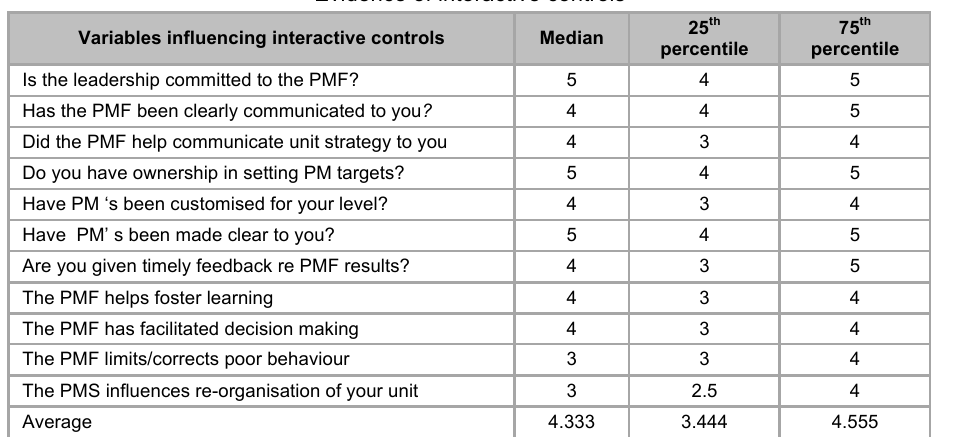
Evidence of interactive